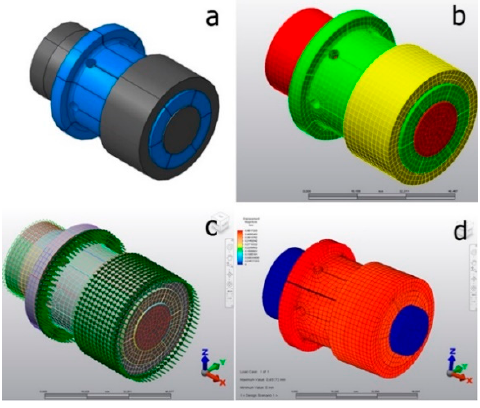
Figure 14. Proposed Finite Element model in ALGOR.